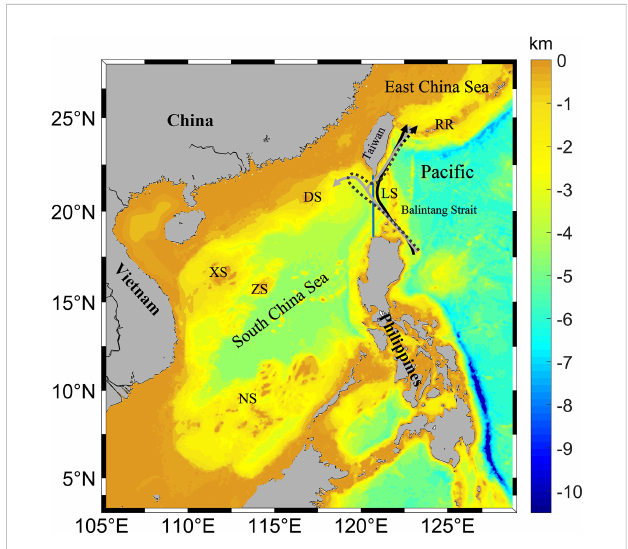
FIGURE 1 Bathymetry of the modelling domain. LS: Luzon Strait, DS: Dongsha Islands, XS: Xisha Islands, ZS: Zhongsha Islands, NS: Nansha Islands, RR: Ryukyu ridge. Arrows depict the type of Kuroshio invasion into the SCS (adapted from Nan et al., 2011): leaping path (solid black arrow), leaking path (solid gray arrow), and looping path (dashed black arrow). The blue line indicates the meridional section at 120.75°E, 18.5°N - 22°N, which is discussed in section